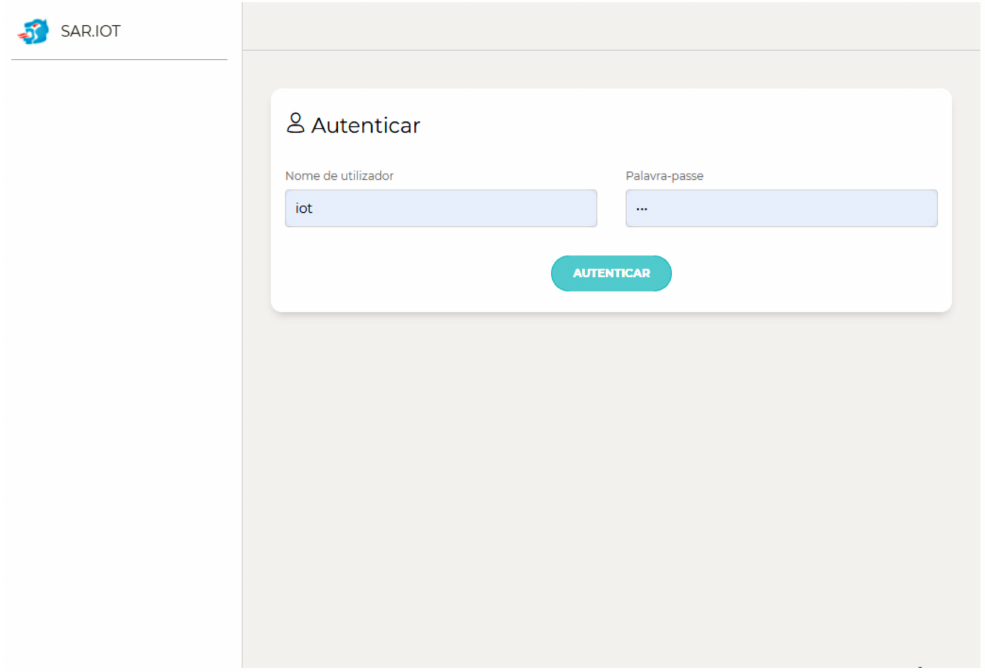
Figure 14. Authentication page.